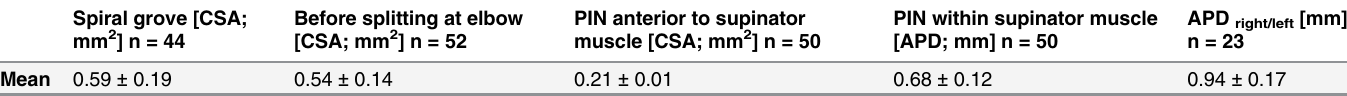
Table 2. Normative values. Before splitting at elbow PIN anterior to supinator PIN within supinator muscle APD right/left [mm] Spiral grove [CSA; [CSA; mm 2 ] n = 52 muscle [CSA; mm 2 ] n = 50 [APD; mm] n = 50 n = 23 mm 2 ] n = 44 Mean 0.59 ± 0.19 0.54 ± 0.14 0.21 ± 0.01 0.68 ± 0.12 0.94 ± 0.17 Cross sectional area (CSA) and antero-posterior diameter (APD) of the radial nerve and the posterior interosseus nerve (PIN) of 26 healthy volunteers (= 52 nerves) presented as mean ± standard deviation.